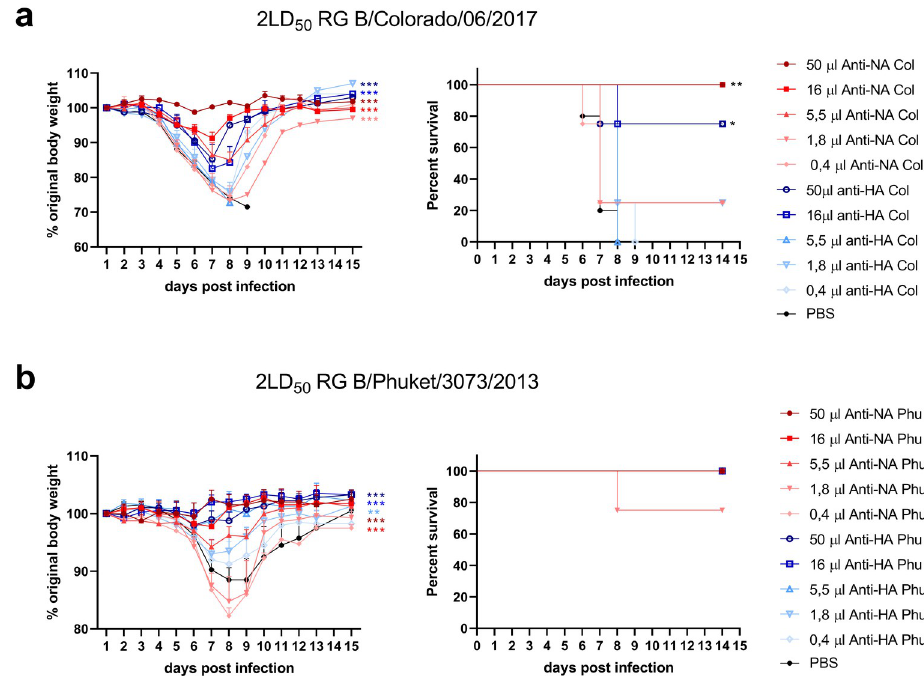
Fig 2. The minimal volume of serum required to confer protection in mice against homologous challenge. BALB/c mice received an intraperitoneal injection of different volumes of anti-NA or anti-HA immune serum ranging from 0.4 to 50 μ l one day prior to infection with 2LD 50 of RG (a) B/Colorado/06/2017 or (b) B/Phuket/3073/2013. Relative body weight values were analysed as repeated measurements using the method of residual maximum likelihood (REML), compared to the PBS control group. Survival analysis was done by the log-rank (Mantel-Cox) test. Significances: � P < 0.05; �� P < 0.01; ��� P < 0.001. Four BALB/c mice were used per group. Data points in the body weight graphs represent averages of the relative percentages of body weight of all mice alive at the time of body weight measurement. Error bars represent s.e.m.